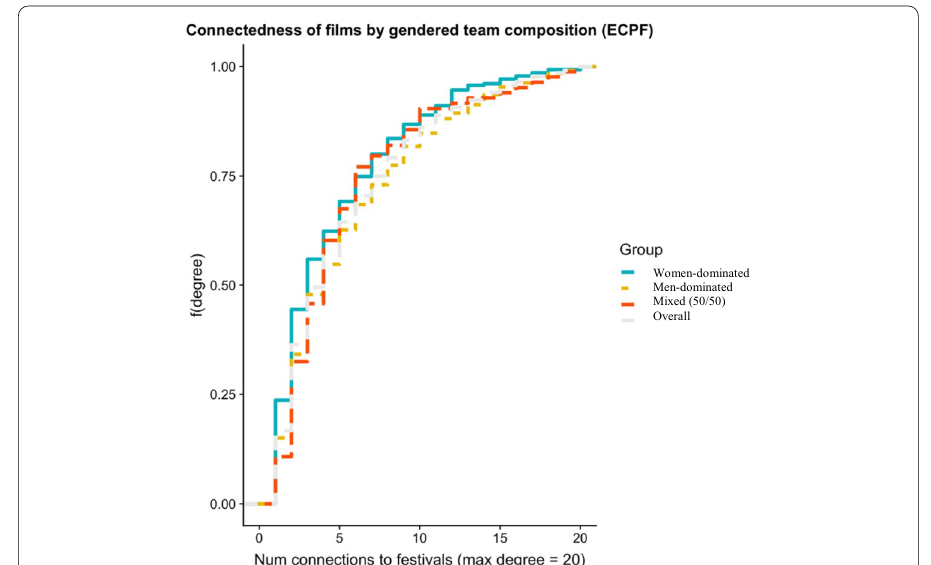
Fig. 16 Cumulative connectedness of films to festivals by gendered film core creative team composition for second operationalization based on cumulative density function of degree centrality. Note : The blue line indicates the cumulative connectedness for films made by women-dominated core creative teams. The yellow line indicates the cumulative connectedness for films made by men-dominated core creative teams. The red line indicates the cumulative connectedness for films made by mixed (50/50) core creative teams and the grey line indicates the cumulative connectedness for all films regardless of gendered film core creative team composition. Each line indicates for any given number of connections to festivals the percentage of films that are below that threshold. For example, about 75% of films made by women-dominated core creative teams are shown at most at 7 festivals. About 75% of films made by men-dominated core creative teams are shown at most at 9 festivals. Note that for improved graphical display the distributions are cut at a